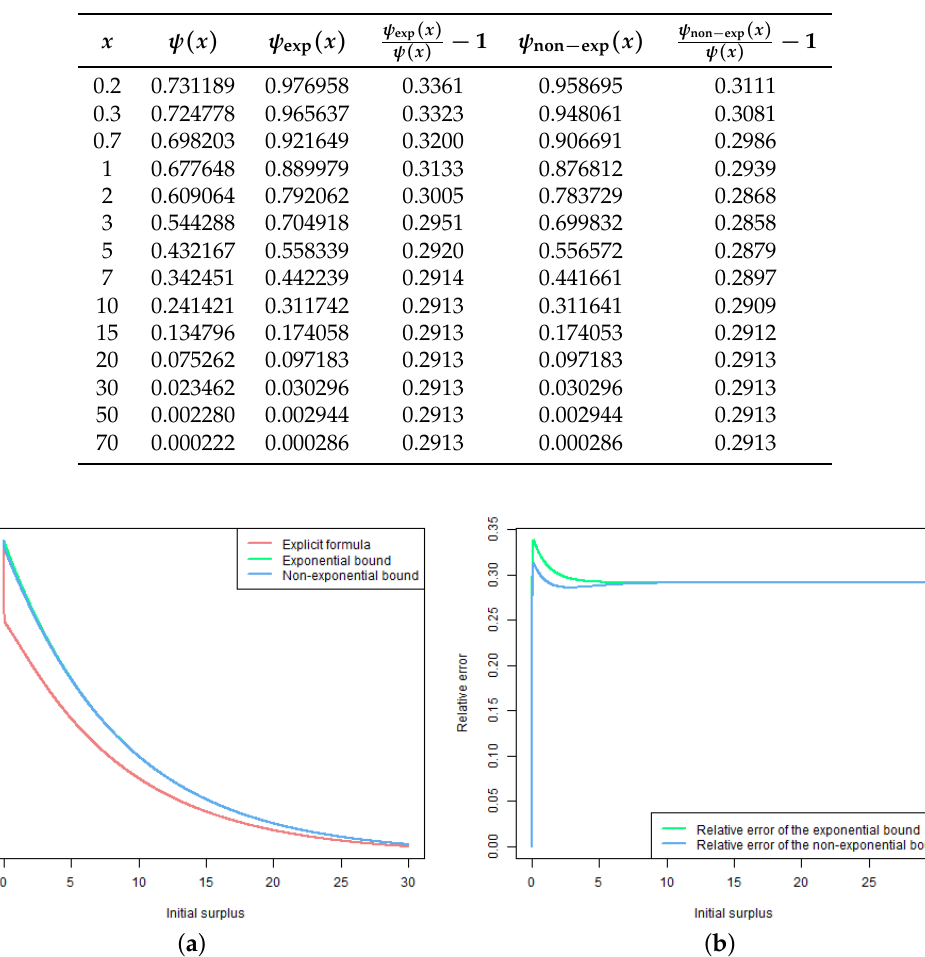
Table 5. Results of computations for the model considered in Example 5.